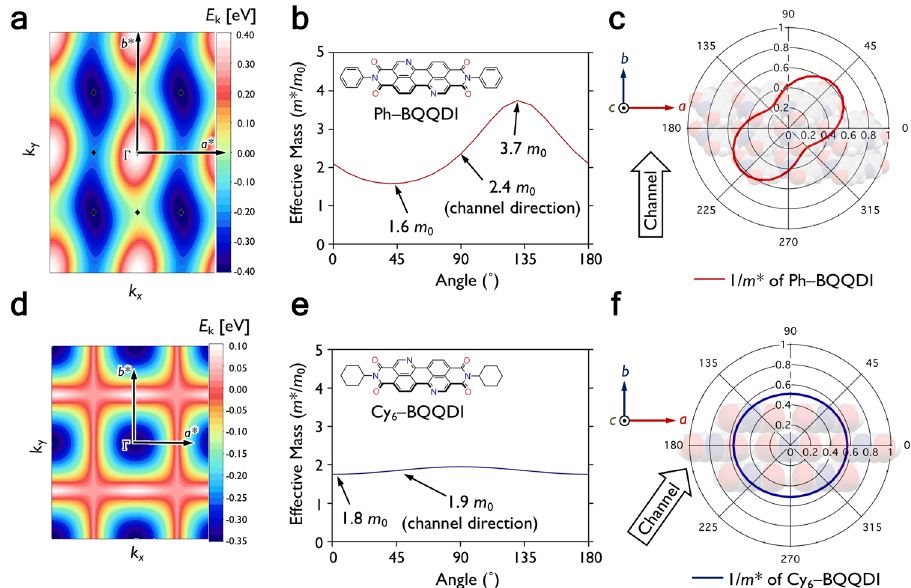
Fig. 6 Charge-transport capabilities calculated by the tight-binding approximation. a and d Contour plots of 2D HOMO bands, where the origin of the energy axis is set to the LUMO level. b and e Angle-resolved effective mass plots. c and f Angle-resolved inversed effective mass plots and